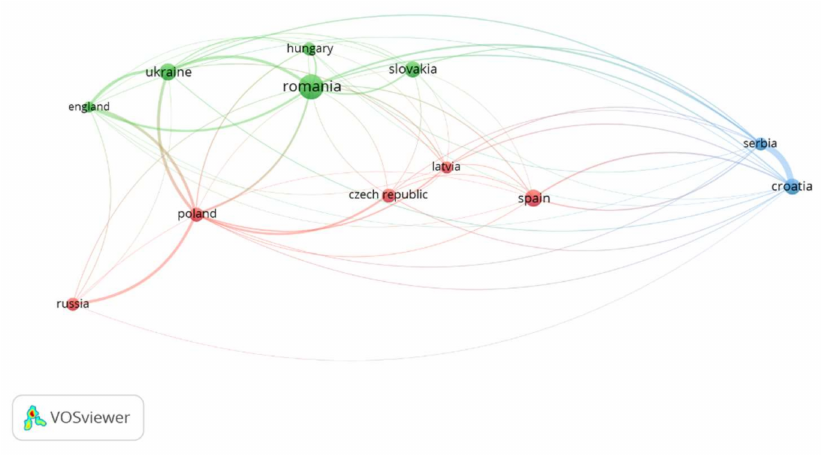
Figure 2. Network of bibliographic